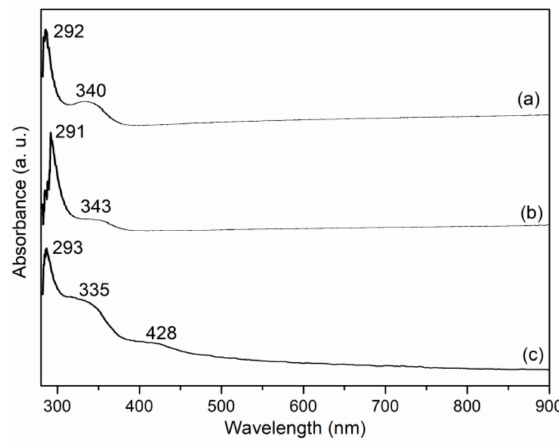
Figure 3. UV-Vis spectra of ( a ) L1, ( b ) Mn1, ( c ) Mn1@aL.